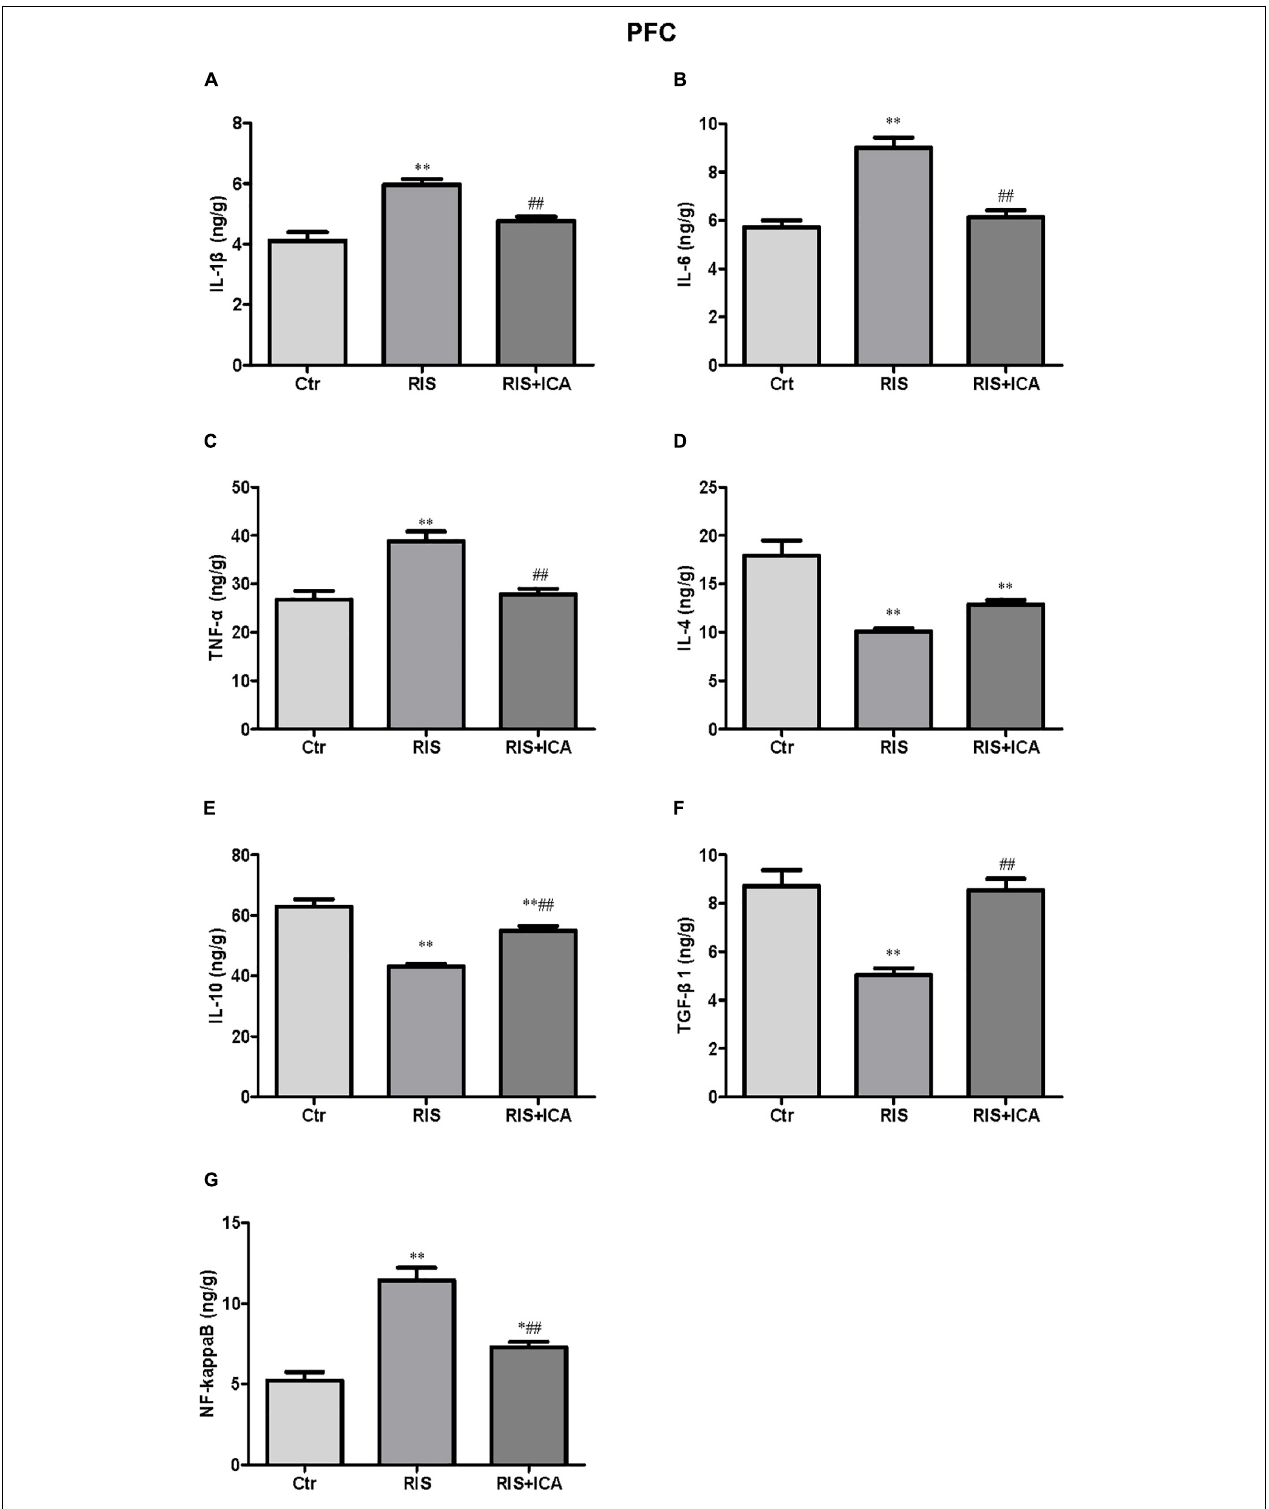
FIGURE 5 | Effect of icariin on cytokines and NF- κ B in the PFC. (A–C) The level of IL-1 β (A) , IL-6 (B) , and TNF- α (C) increased in the RIS group, and icariin relieved the alteration. (D) The levels of IL-4 decreased in the RIS group, but icariin failed to relieve the alteration. (E,F) RIS significantly decreased the level of IL-10 (E) and TGF- β 1 (F) compared with controls, and icariin could reverse the change. (G) NF- κ B levels increased in the RIS group, and icariin relieved the alteration. The results are expressed as the mean ± SEM, n = 6. ∗ p < 0.05, ∗∗ p < 0.01 vs. control group; ## p < 0.01 vs. RIS group.